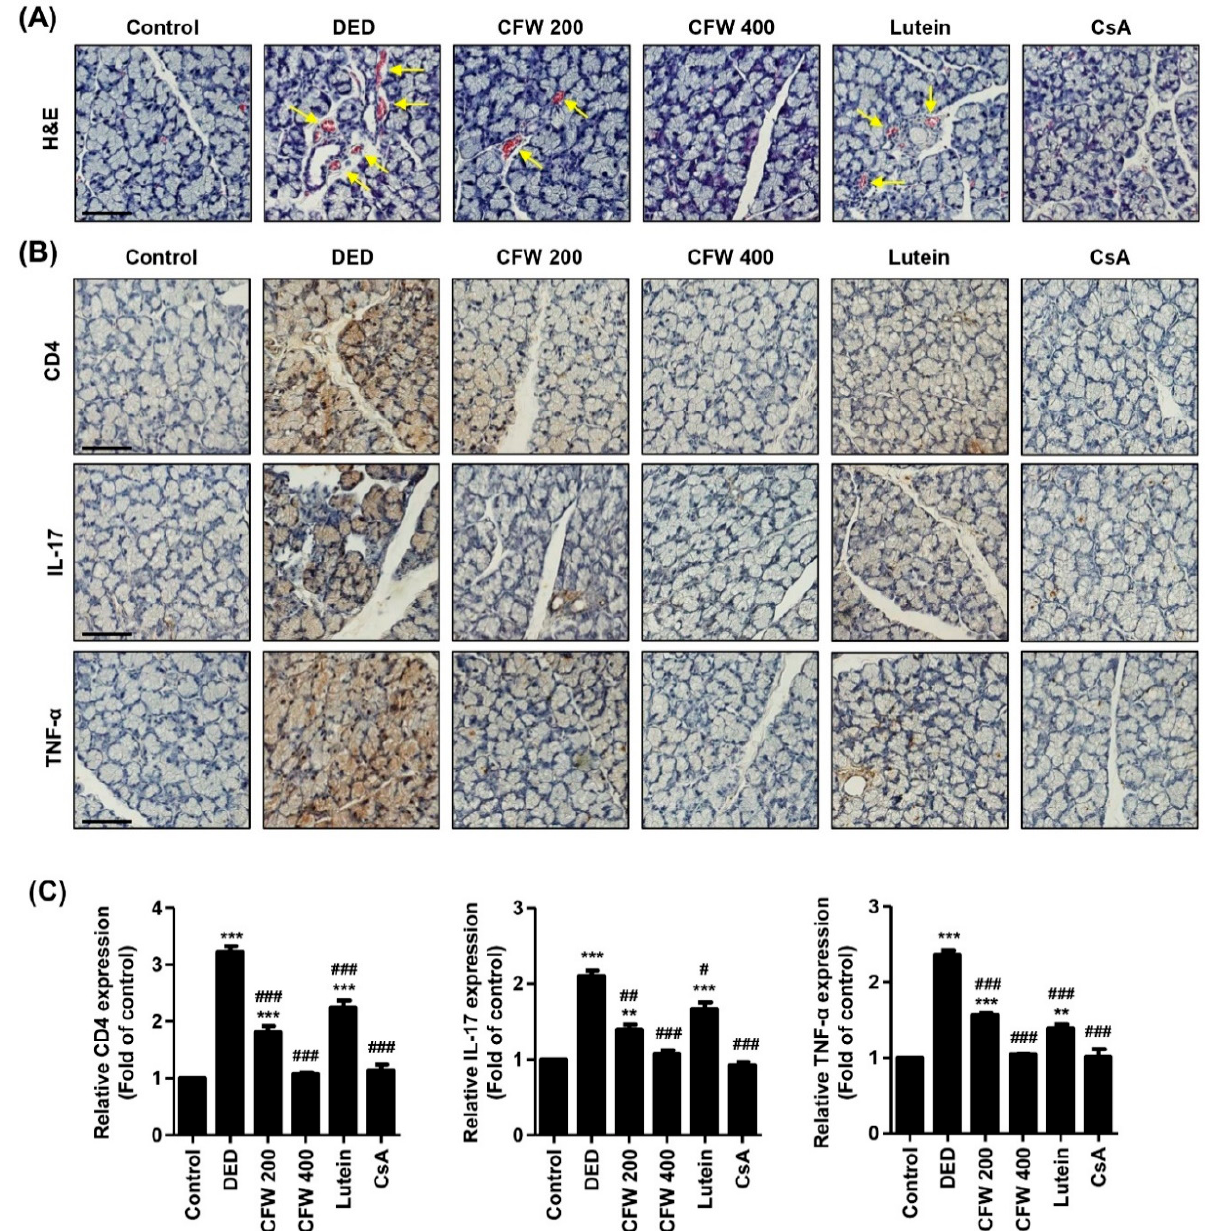
Figure 4. Effect of oral administration of CFW on inflammation of the lacrimal gland in PM 2.5 -induced DED rats. ( A ) Representative images of H&E staining in the lacrimal gland ( n = 6). Yellow arrows indicate neo-vessels. Scale bar, 50 μ m. ( B ) Representative images of immunohistochemical staining for CD4, IL-17, and TNF- α in lacrimal gland sections ( n = 5). Scale bar, 50 µ m. The brown-stained precipitates indicate the presence of the target antigen. ( C ) The stained area of the photograph was quantitative analyzed using ImageJ ® and calculated in terms of the fold of the control. ** p < 0.01 and *** p < 0.001 compared to the control group. The data are expressed as the means ± standard deviation ( n = 3). # p < 0.05, ## p < 0.01 and ### p < 0.001 compared to the PM 2.5 -induced DED group.